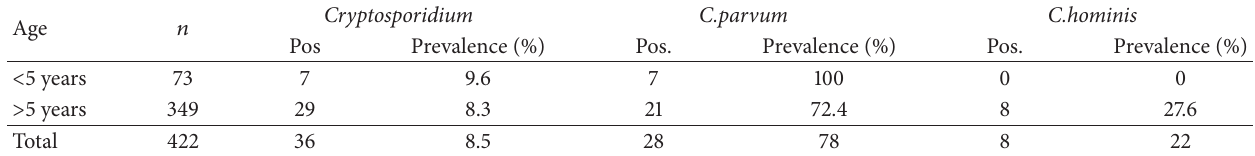
Table 3: Prevalence of Cryptosporidium and Cryptosporidium genotypes in the farm workers and their household members based on age. Age 𝑛